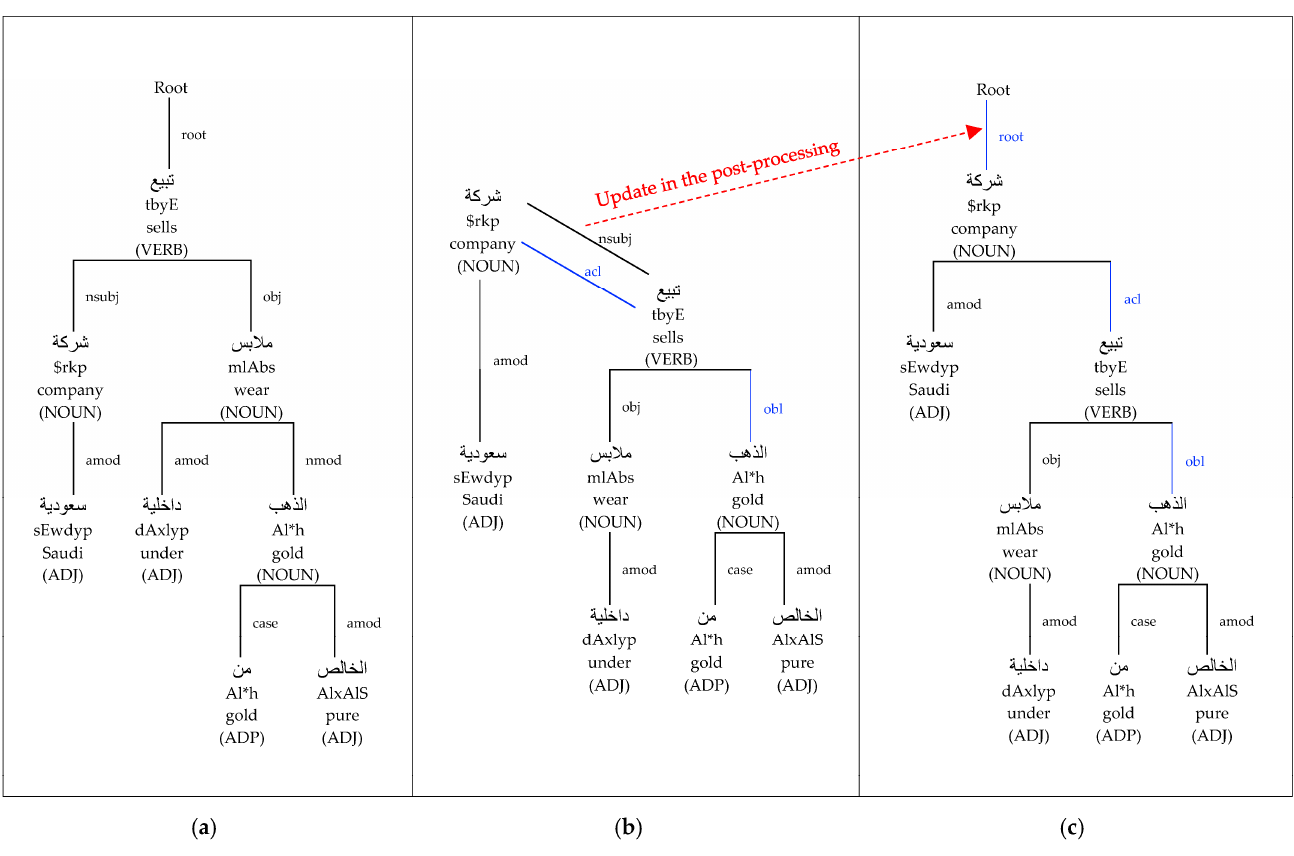
Figure 7. Gold, predicted, and final parse trees for Example (1). Blue edges are incorrect. ( a ) Gold parse tree. ( b ) Predicted parse tree. ( c ) Final parse tree.